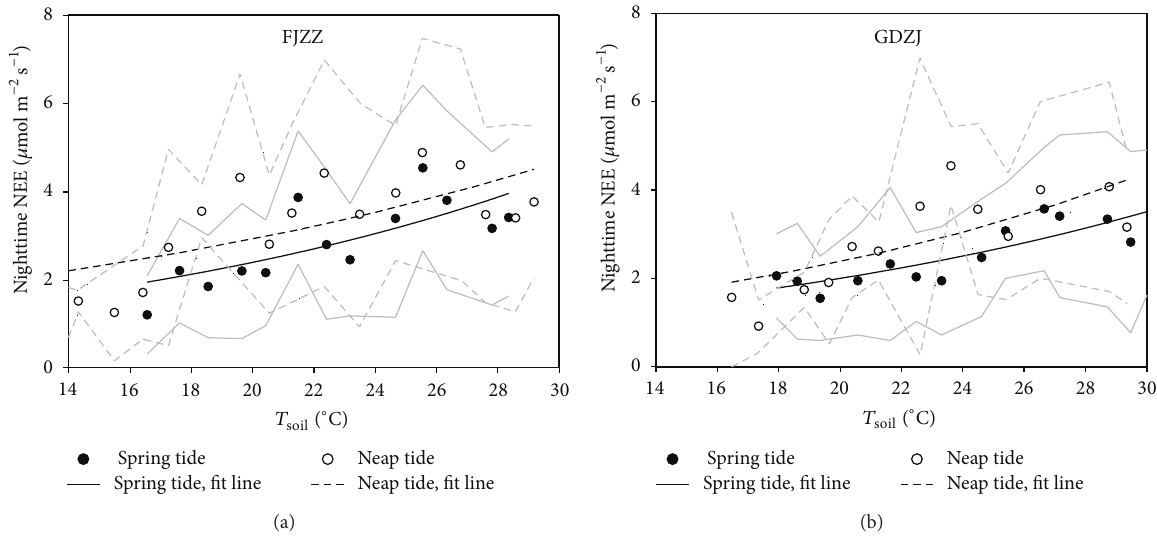
Figure 6: Nighttime NEE versus soil temperature at 10cm depth partitioned by spring tides and neap tides of the year 2010 at FJZZ and GDZJ. Each subset of the data was divided into bins corresponding to the increasing soil temperature, and the averages (circles) and standard deviation (solid and dashed grey lines) were computed for each bin. Fit curves (solid and dashed black lines) from linear regression analysis of the averages of nighttime NEE versus temperature based on (3) were included.